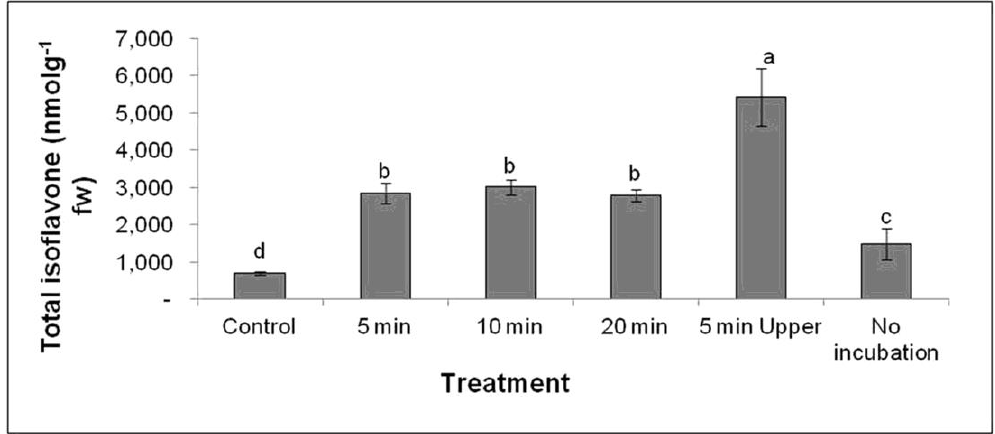
Figure 4. Total isoflavone concentration in Glycine max cv. Daepung after UV-C treatment for di ff erent time periods (unit: nmol g − 1 of fresh weight). Here, leaves without UV-C irradiation and incubated in the dark are considered as the control. The leaves without UV-C irradiation as well as without incubation are indicated as “no incubation”. The leaves in which adaxial (upper) surface facing the UV light source, is termed as “5 min Upper”. The error bars represent the means ± standard deviation ( n = 3). Means with the same letter are not significantly di ff erent ( p ≤